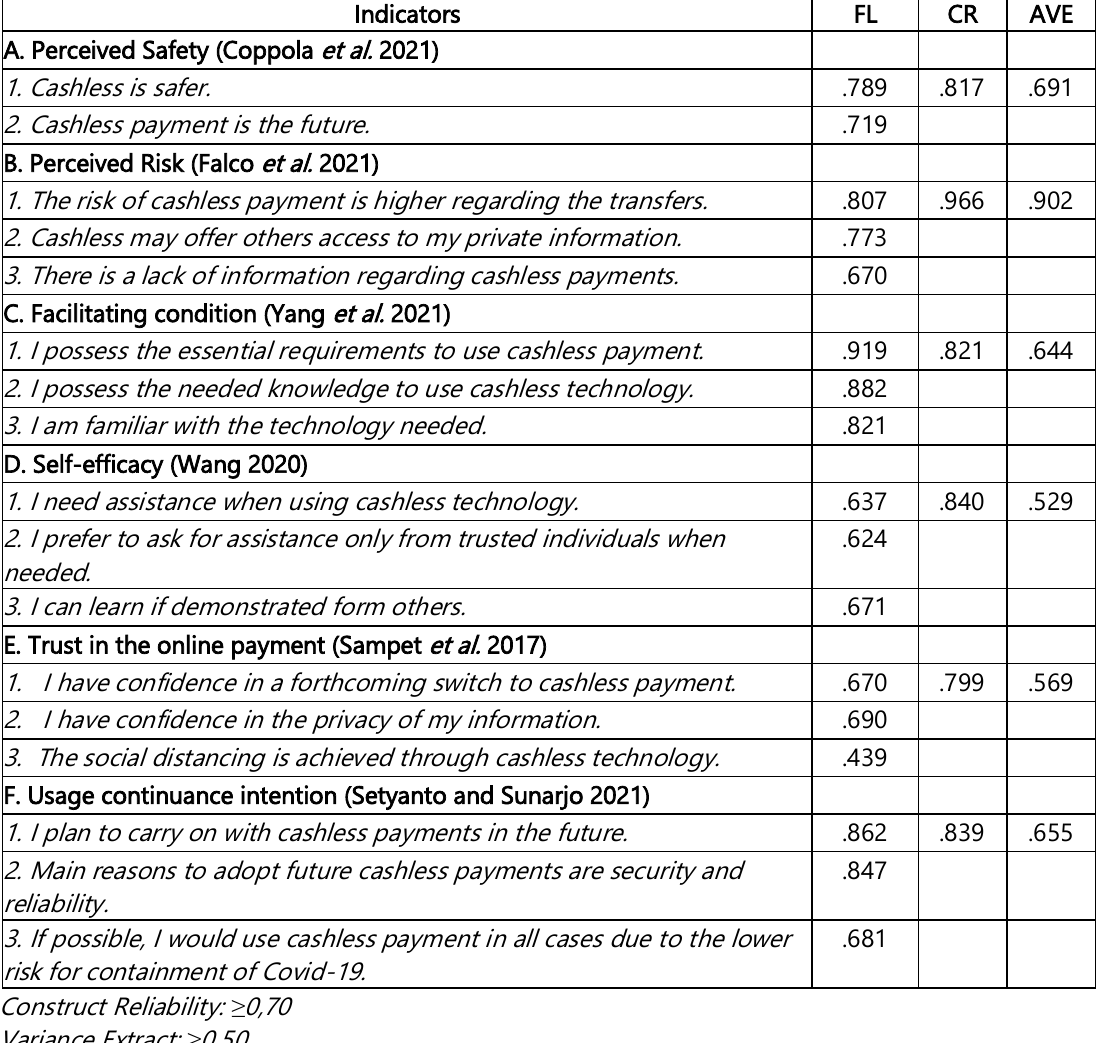
Table 2: Confirmatory Factor Analysis Statistics (Source: Authors‟ depiction 2021)